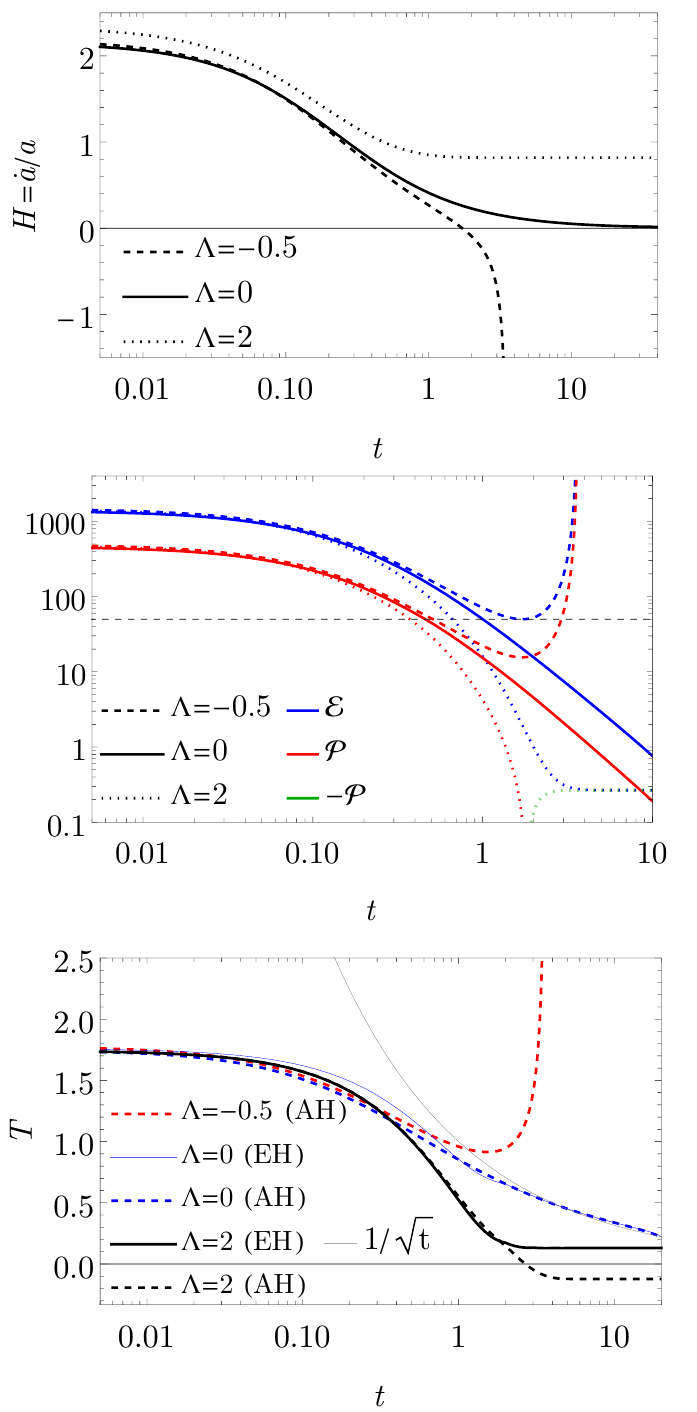
Figure 2 . Evolution of the Hubble rate (top), of the energy density and pressure (middle), and of the effective temperature (bottom), for G = 1 / 2500 and three different values of Λ